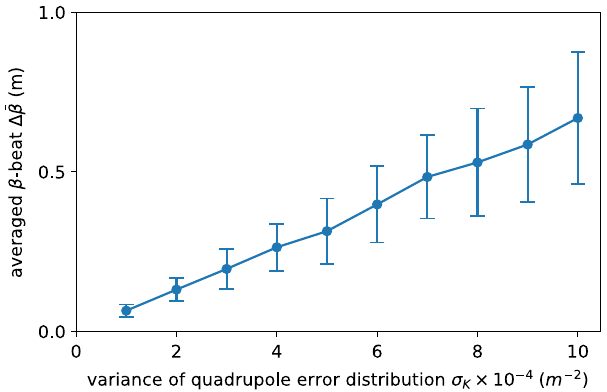
FIG. 1. Statistic illustration of the horizontal β -beat due to the random quadrupole errors. This linear correlation with gradually increasing variance are calculated with the NSLS-II ring lattice model in advance. Once an averaged β -beat is measured, its corresponding variance of quadrupole error distribution can be used as the prior probability to prevent